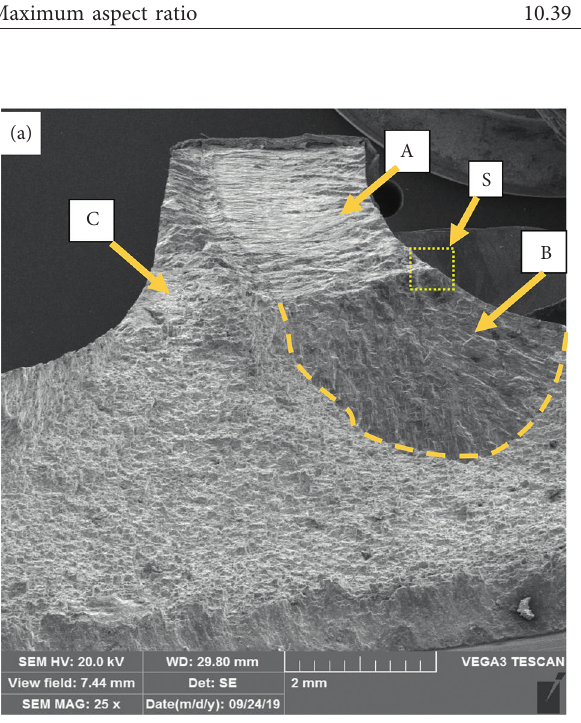
Figure 4: Macrostructure of fracture surface for sample